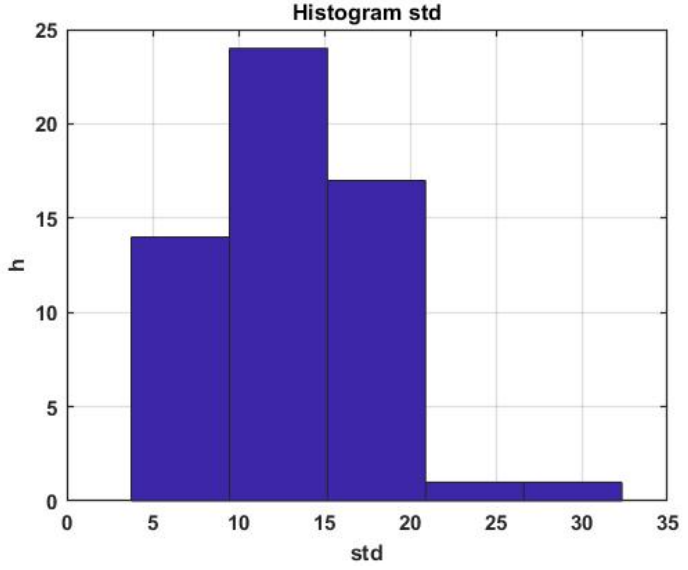
Figure 11. Forecast error rate histogram.